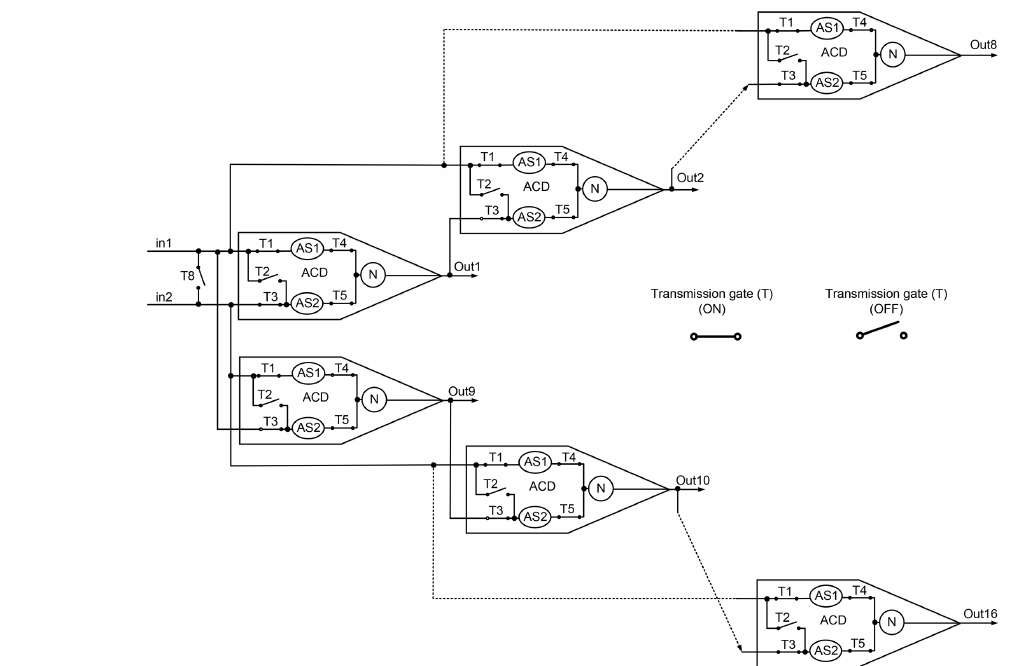
Figure 6. This figure shows that the ASRC has a normal and adaptation mode. In the normal mode, both synapses of the ACD are connected to the neuron. The switching state of the transmission gates in the normal mode, T1, T3, T4, and T5, are on, and T2 and T8 are off. The adaptation mode has two states. Only the first synapse is connected to the neuron in the first state. The switching state of the transmission gates in the first state of the adaptation mode, T1, T4, and T8, are on, and T2, T3, and T5 are off. Only the second synapse is connected to the neuron in the second state. The switching state of the transmission gates in the second state of the adaptation mode, T2, T5, and T8, are on, and T1, T3, and T4 are off.